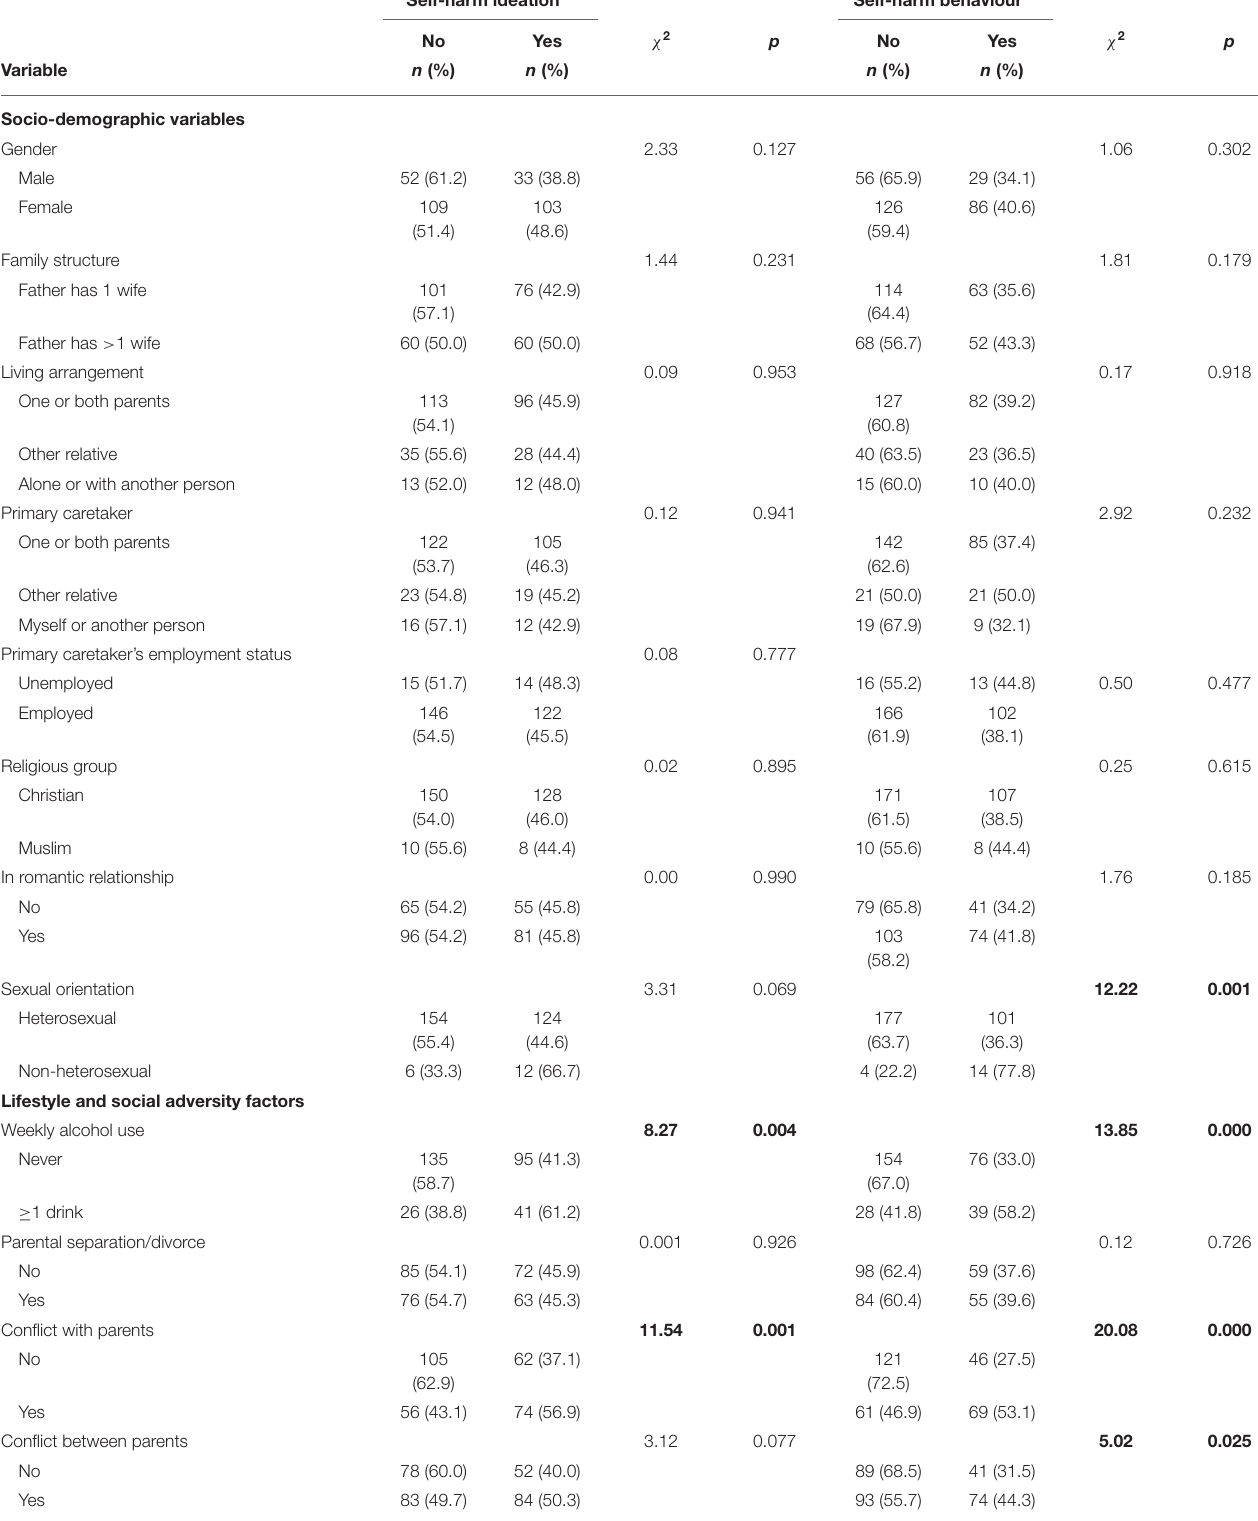
TABLE 2 | Bivariable analysis (Chi square